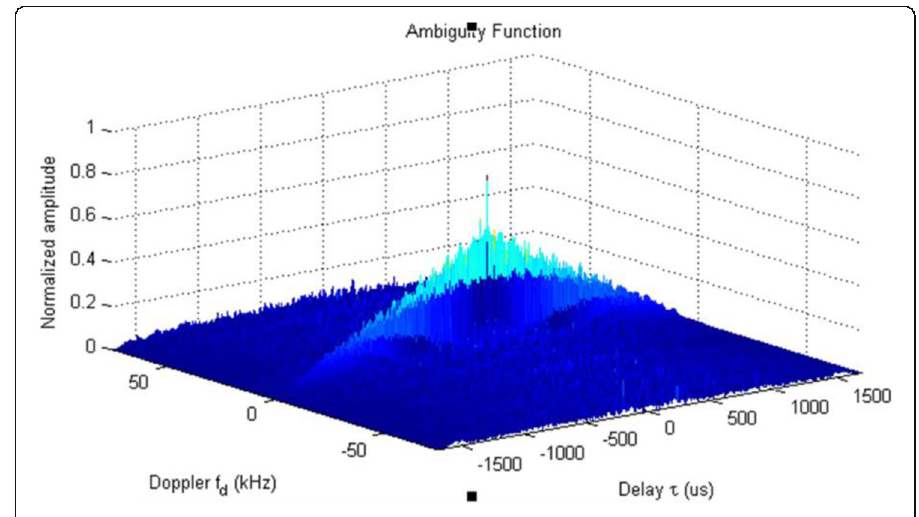
Fig. 12 Doppler tolerance of f C 6